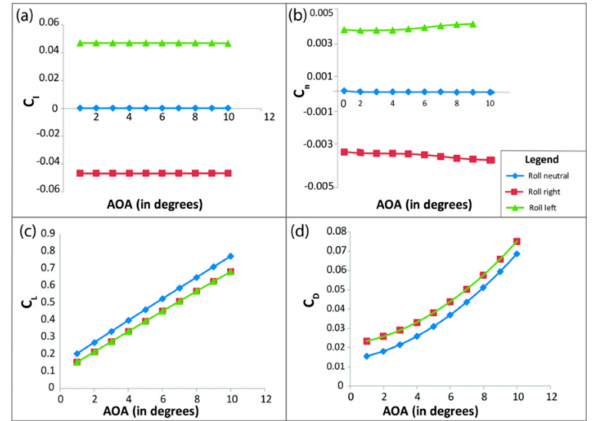
Figure 12. Change in aerodynamic parameters due to aileron deflection. Here, subfigure ( a ) shows the variation of C l (coefficient of pitching moment), ( b ) shows the variation of C n (coefficient of the yawing moment), ( c ) shows the variation of C L (coefficient of lift), and ( d ) shows the variation of C D (coefficient of drag) with varying angles of attack and a fixed aileron deflection of 10 ◦